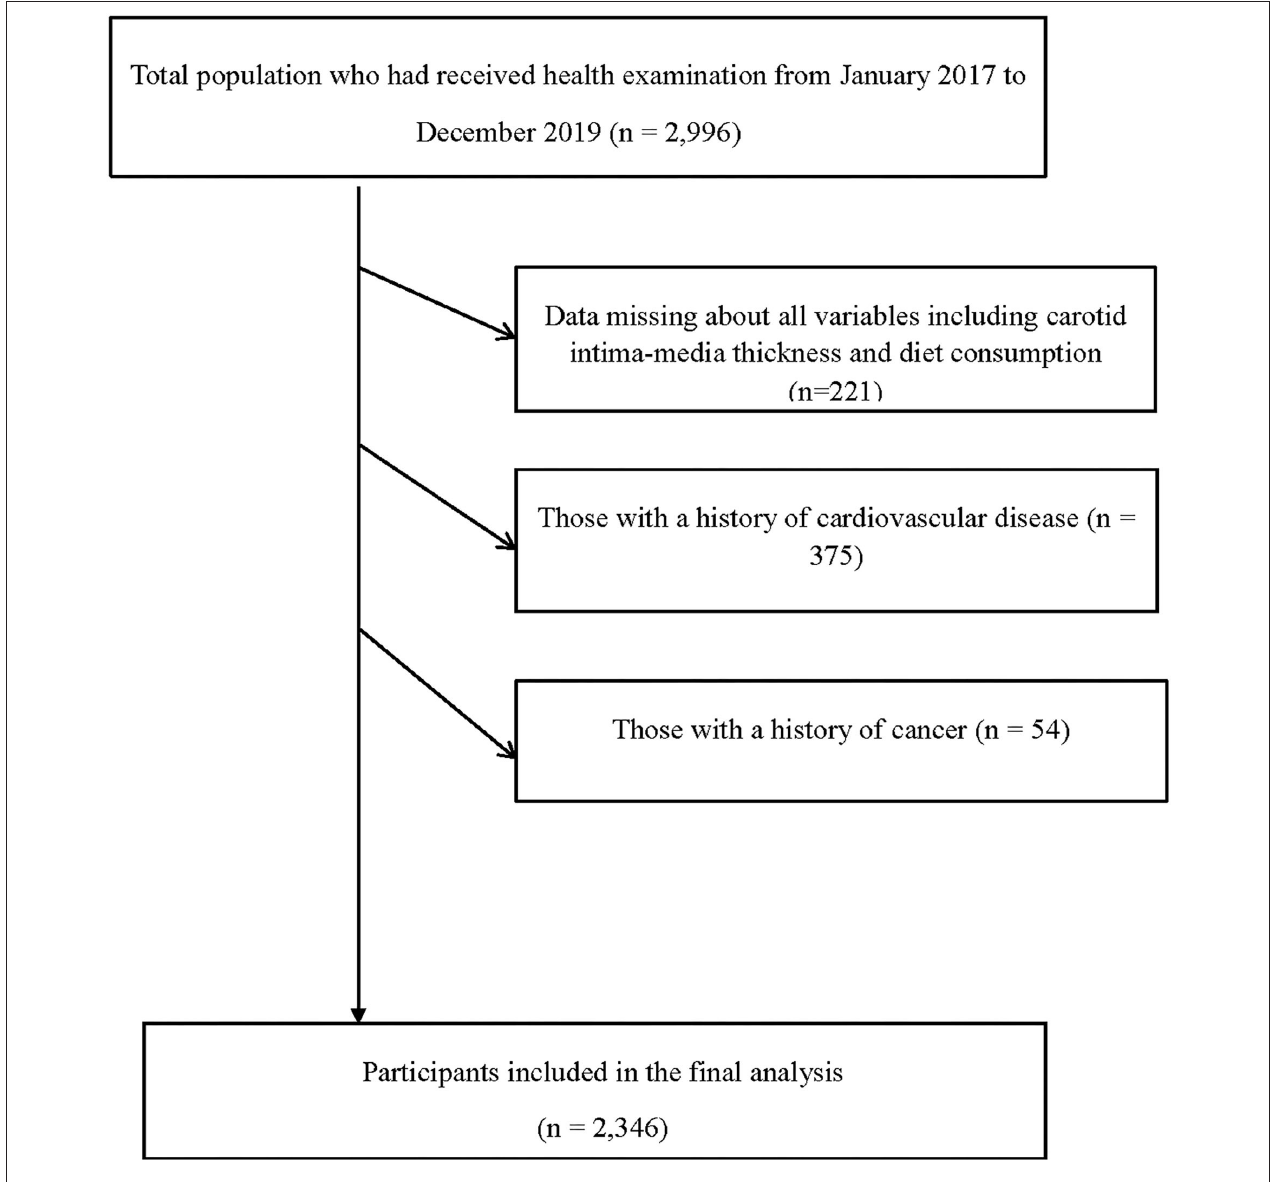
FIGURE 1 | Flow diagram showing the process for the selection of eligible